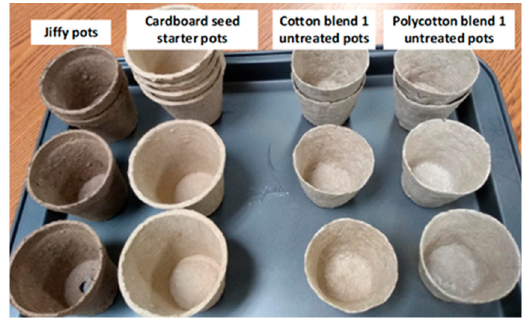
Figure 4. Seedling pots used for compressive strength test.